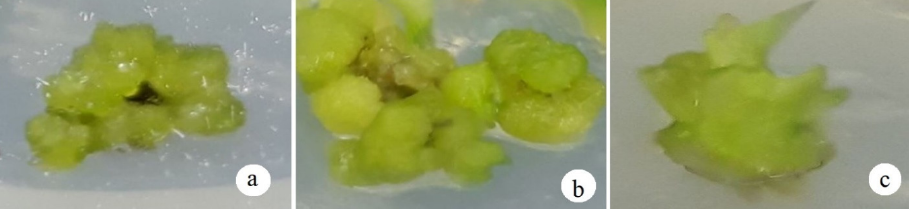
Figure 1. Protocorm development stages: ( a ) seeds started to increase in volume and size (4 weeks after implantation), ( b ) the initiation of protocorm (4–6 weeks after implantation), and ( c ) protocorm with one leaf primordium (6–8 weeks after